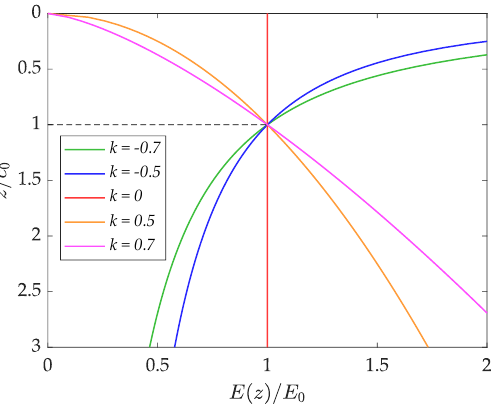
Figure 13. Power-law in-depth grading plotted for the five characteristic cases 𝑘 = −0.7 , = − 0.5 k , = 0 k , = 0 . 5 k and 𝑘 = 0.7 . k = 0, k = 0.5 and k =